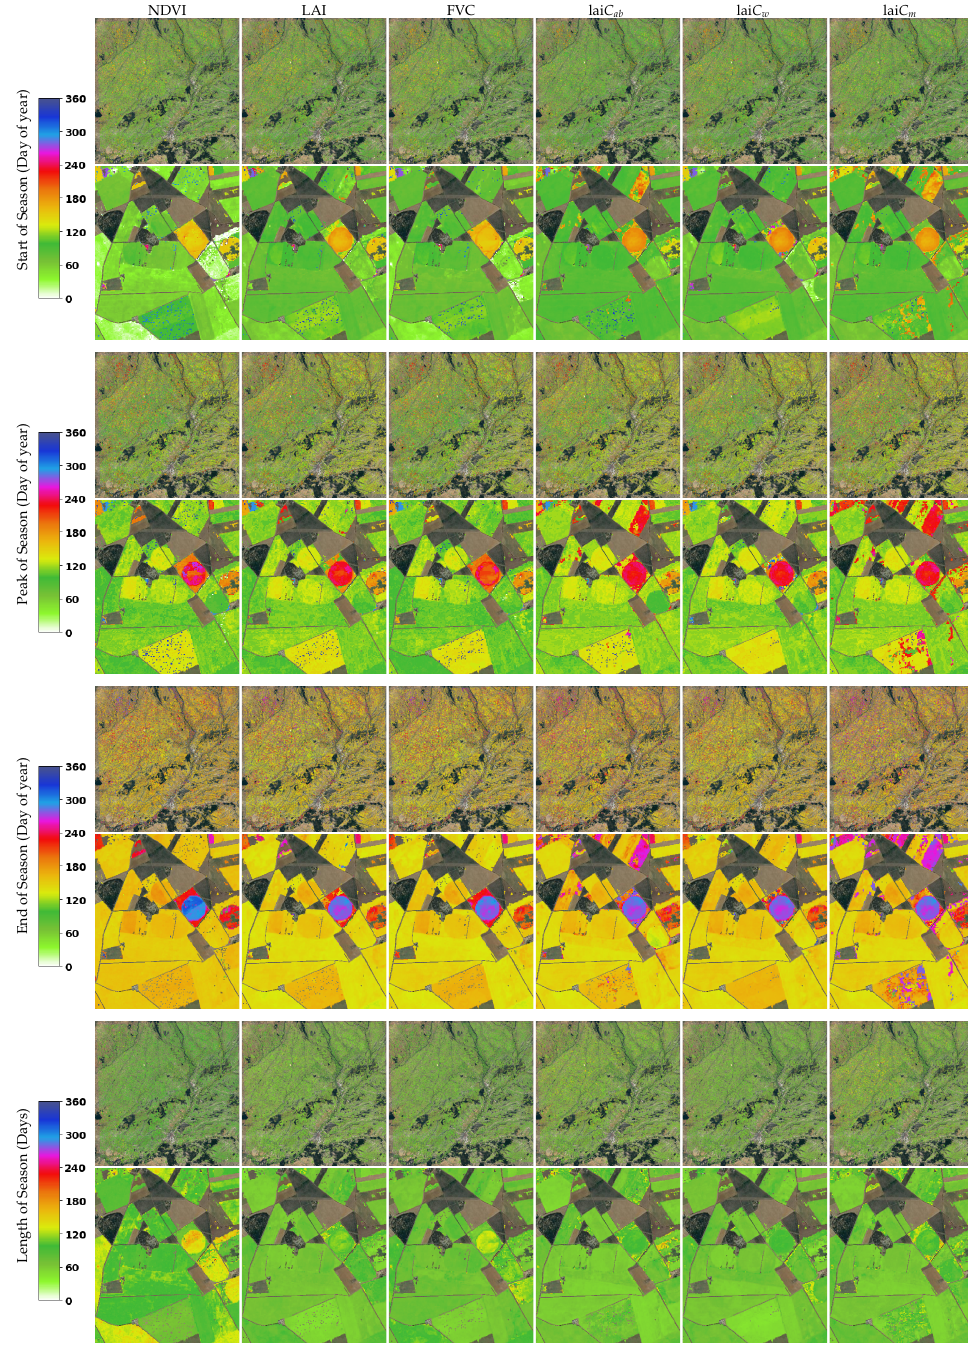
Figure 7. LSP values (SOS, POS, EOS, and LOS) of NDVI and crop traits for 30TUM in the year 2019 (Castile and Leon, Spain); underneath, a zoom-in of the study site. See Figure 2 for the geo-information.